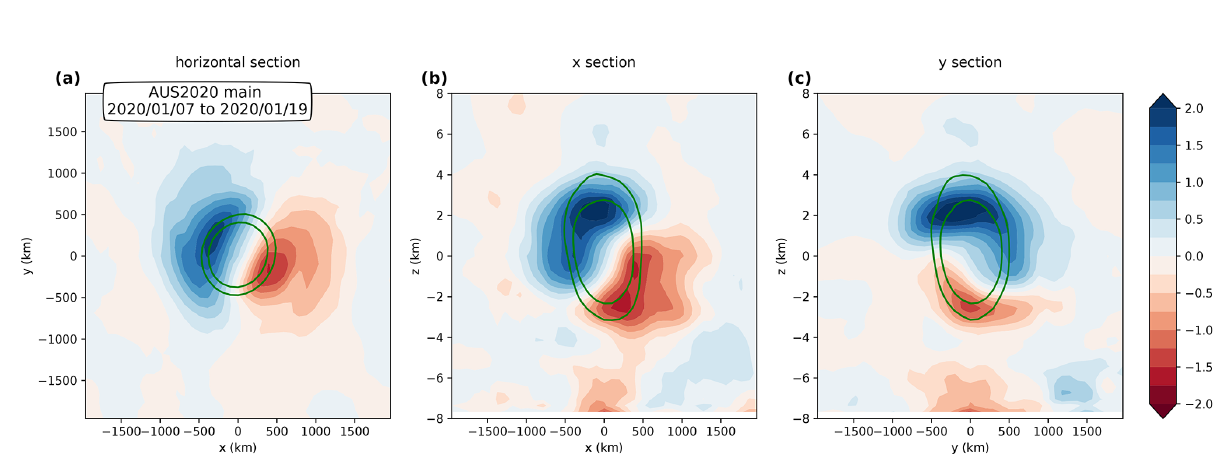
Figure B1. Same as Fig. 10 but for the Koobor Lait PV increments during the 7–19 January 2020 time period. Note the different colour bar compared with Fig. 10. The different magnitude of the increments is due to the contrasting ascent speed of the vortex in the log-pressure altitude coordinate (250md − 1 in January vs. 150md − 1 in